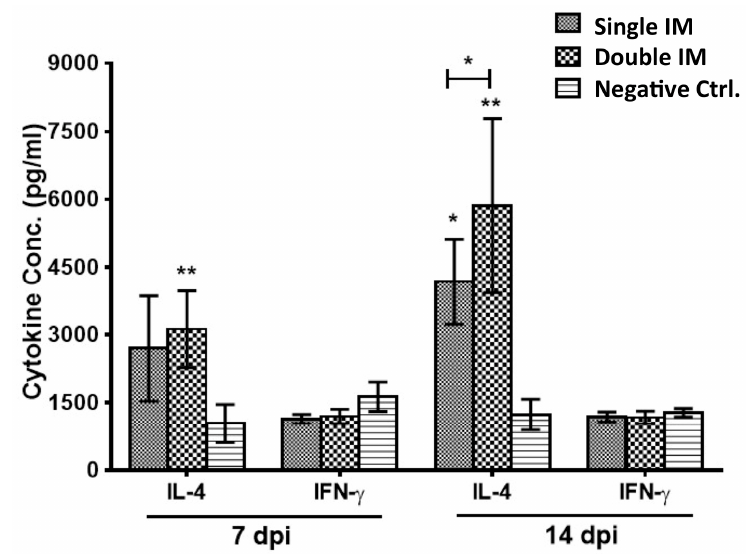
Figure 2. FAdV-4 specific T helper 1 (Th1)/Th2 cytokines responses. Th1 (interferon (IFN)- γ ) and Th2 (interleukin (IL)-4) cytokines in serum of chickens were detected by ELISA. A strong Th2 response was induced in the vaccinated chickens. Significant differences between Th1 and Th2 cytokines (IFN- γ and IL-4) were evaluated at (* p < 0.05) or (** p < 0.01).